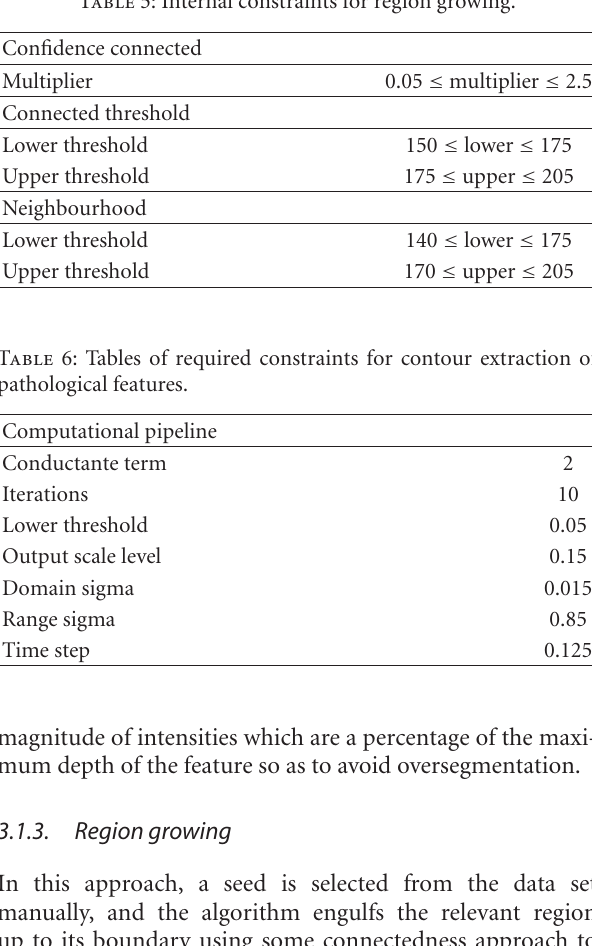
Table 5: Internal constraints for region growing.